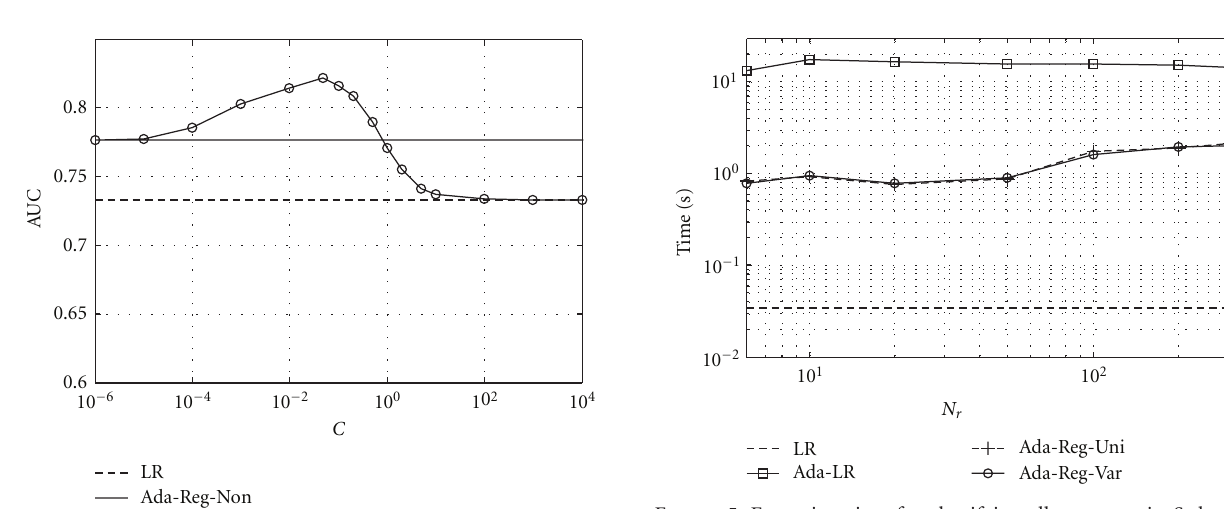
Figure 5: Execution time for classifying all test cases in S 2 by the di ff erent classifiers. The regularization approaches (Ada-Reg-Uni and Ada-Reg-Var) are similar in execution time, and are notably faster than the adaptive classifier in [22]